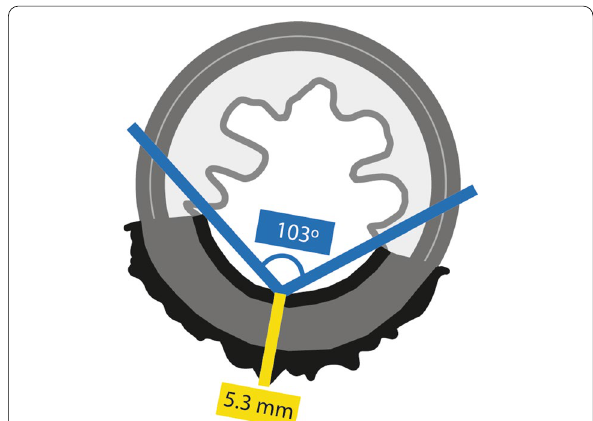
Fig. 9 Scar depth angle and thickness measurements should be performed on the axial central slice of the tumour. For scar depth angle measurements of small (< 180°) tumour scars, the endoluminal centre of the scar serves as pivot while the angle lines cross the endoluminal extremities of the scar (in blue). In > 180° scars, the pivot should also be central but the angle lines should cross the endoluminal aspect of the scar at 180° of the rectal circumference and no more than that. The same applies to circumferential scars but in such cases, the pivot should be placed at the most invasive tumour front if there is one, or randomly if there isn´t. The most important thing to keep in mind is measuring at the exact same location in both first and second post-NAT MR imaging examinations. Scar thickness should be measured at pivot level, at the second MR imaging assessment. Measurement corresponds to a line that transverses tumour scar in depth, perpendicularly to it (in yellow), from inner to outer surface, irrespectively of it signal